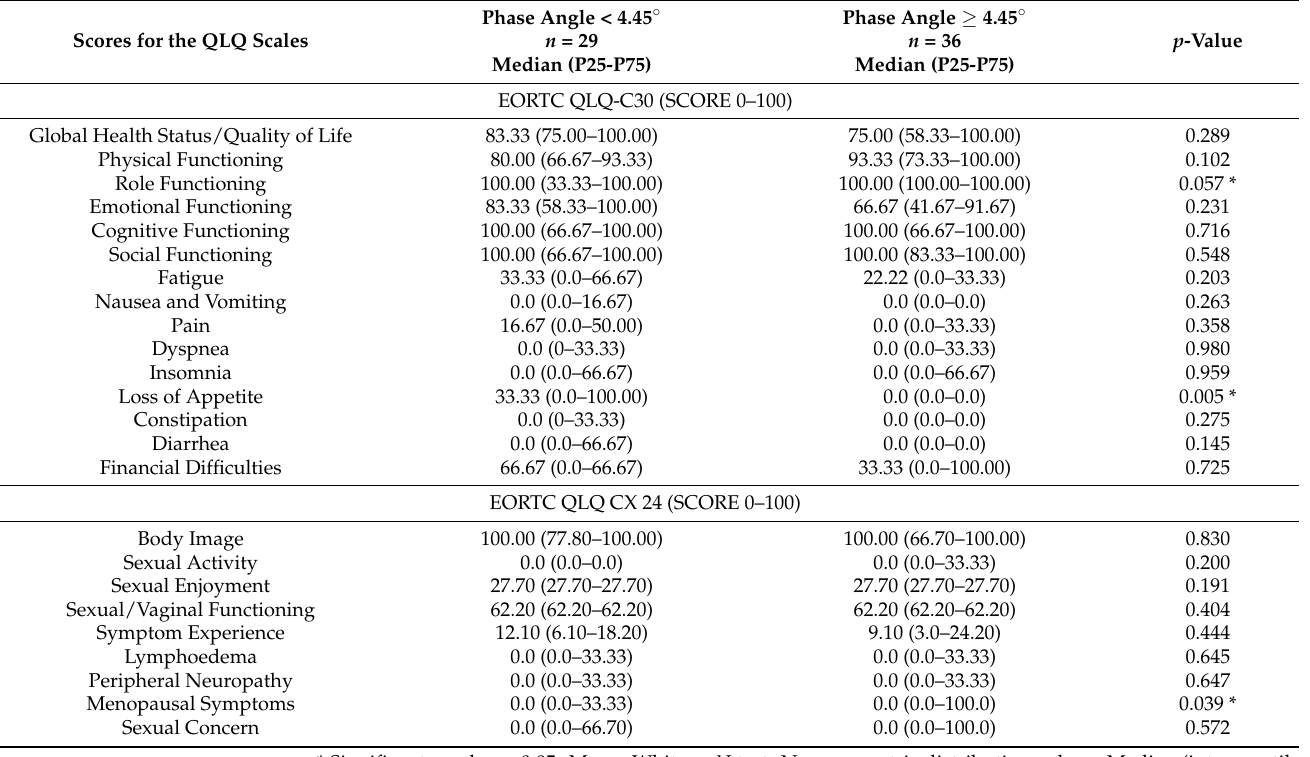
Table 3. Comparison of EORTC QLQ-C30 and EORTC QLQ CX 24 scores between uterine cervical cancer patients with low PA and normal PA.